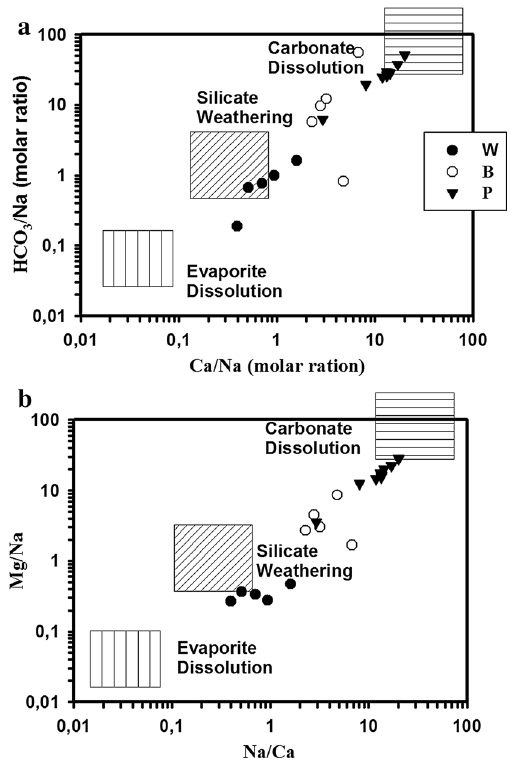
Fig. 5 Mixing diagrams of Ca/Na versus HCO 3 /Na and Ca/Na versus Mg/Na for silicate and carbonate minerals in the Upper Precambrian sedimentary aquifer of the northwestern Burkina